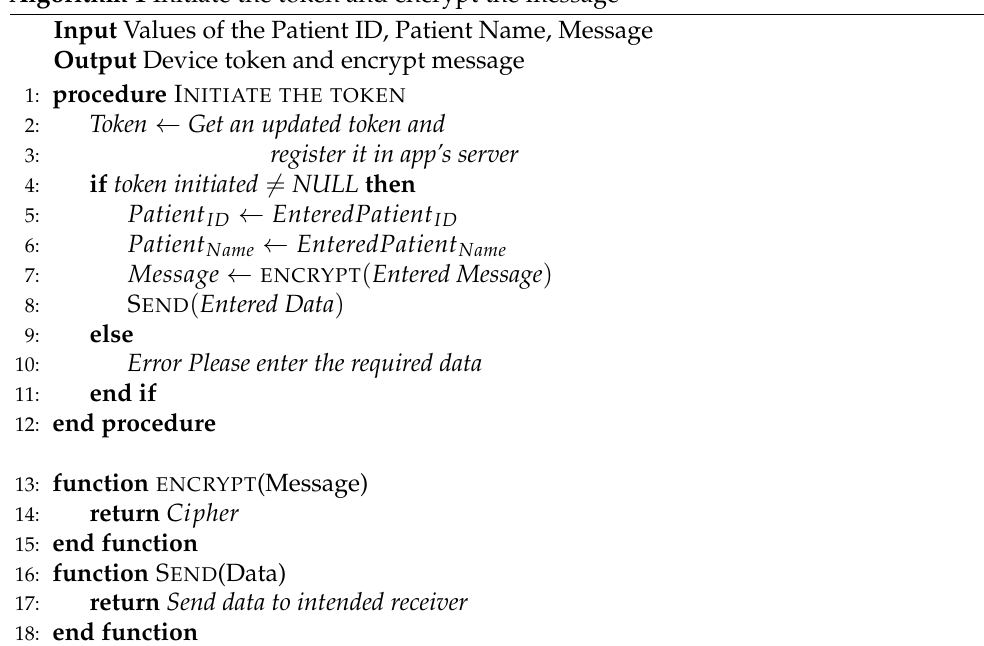
Algorithm 1 Initiate the token and encrypt the